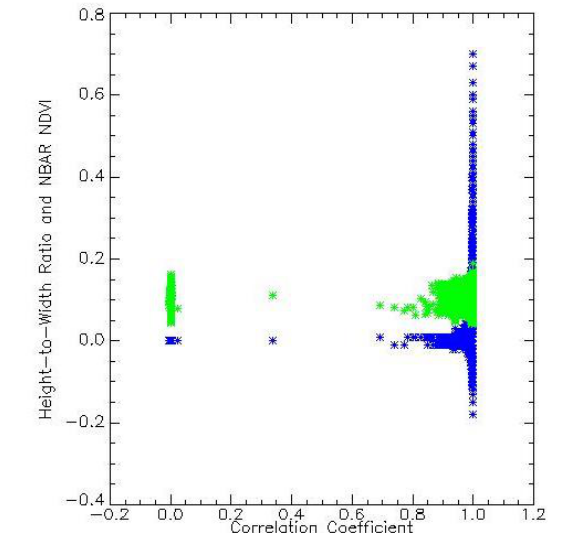
With the derived best fit height-to-width ratio (H) substituted back into equation 1, the model generally provides a good fit to NDVI derived across the same range of view angles based on the MODIS BRDF representation.